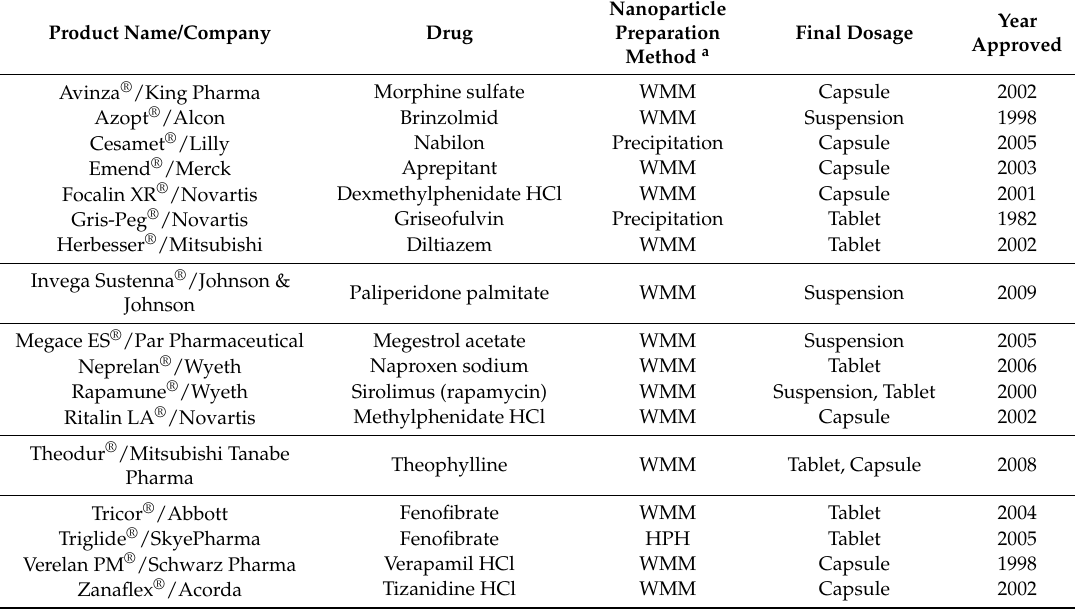
Table 1. Drugnanoparticle-basedmarketedproductsapprovedbyFDA(AdaptedfromMalamatari et al. [31] with permission from Elsevier,